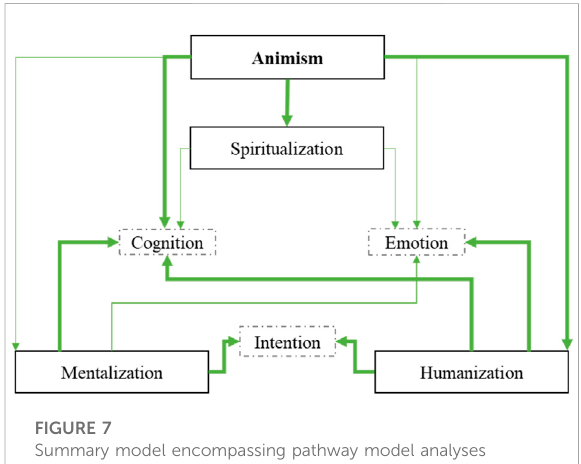
FIGURE 7 Summary model encompassing pathway model analyses frombothExperiment1andExperiment2.The fi gureonlypresents the signi fi cant paths (all positive). Paths in bold revealed to be signi fi cant in both